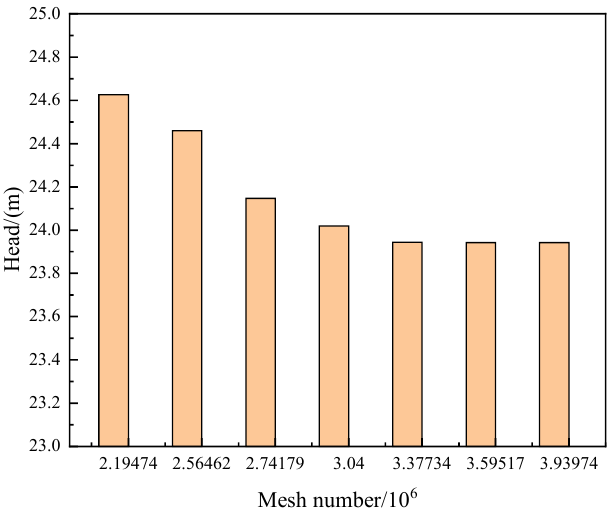
Figure 3. Mesh independent verification.